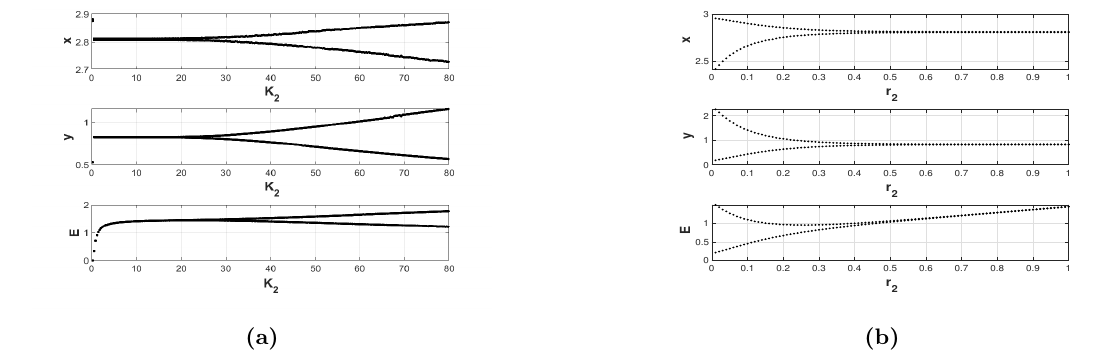
Figure 2. (a) Bifurcation diagram for K 2 . (b) Bifurcation diagram for r 2 .